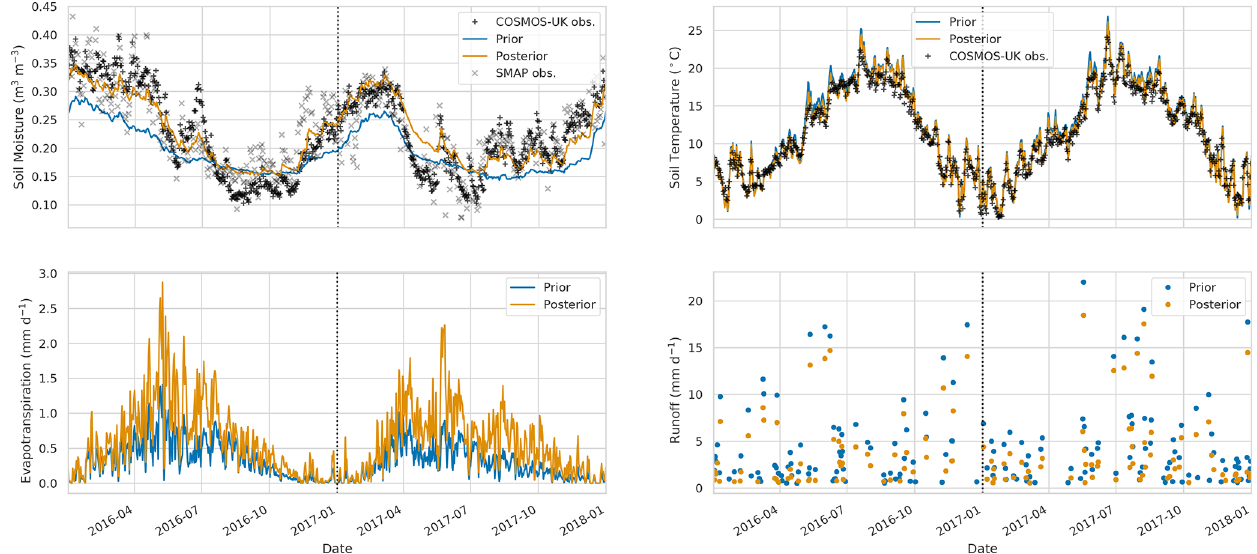
Figure 11. Time series of water budget variables and soil temperature at Cardington COSMOS site. Black plus signs: COSMOS-UK ob- servations, grey crosses: SMAP observations for closest 9km pixel, blue line: prior JULES estimate for closest 1km grid cell, orange line: posterior JULES estimate for closest 1km grid cell.